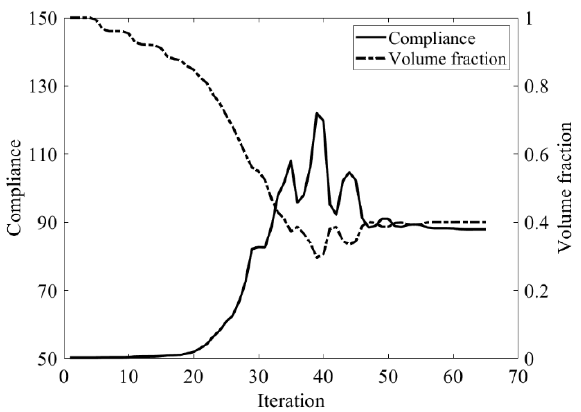
Figure 30. Convergence history of the compliance and the volume fraction for L-shaped beam by CBT level set topology optimization.